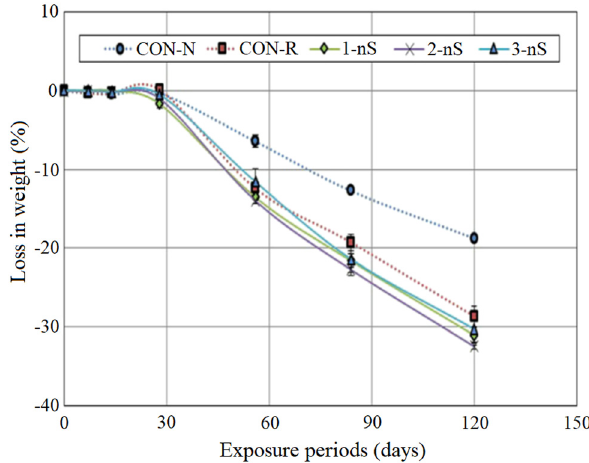
Figure 21: E ff ect of nano - SiO 2 on the weight loss of geopolymer concretes due to sulfuric acid assault [ 100 ]